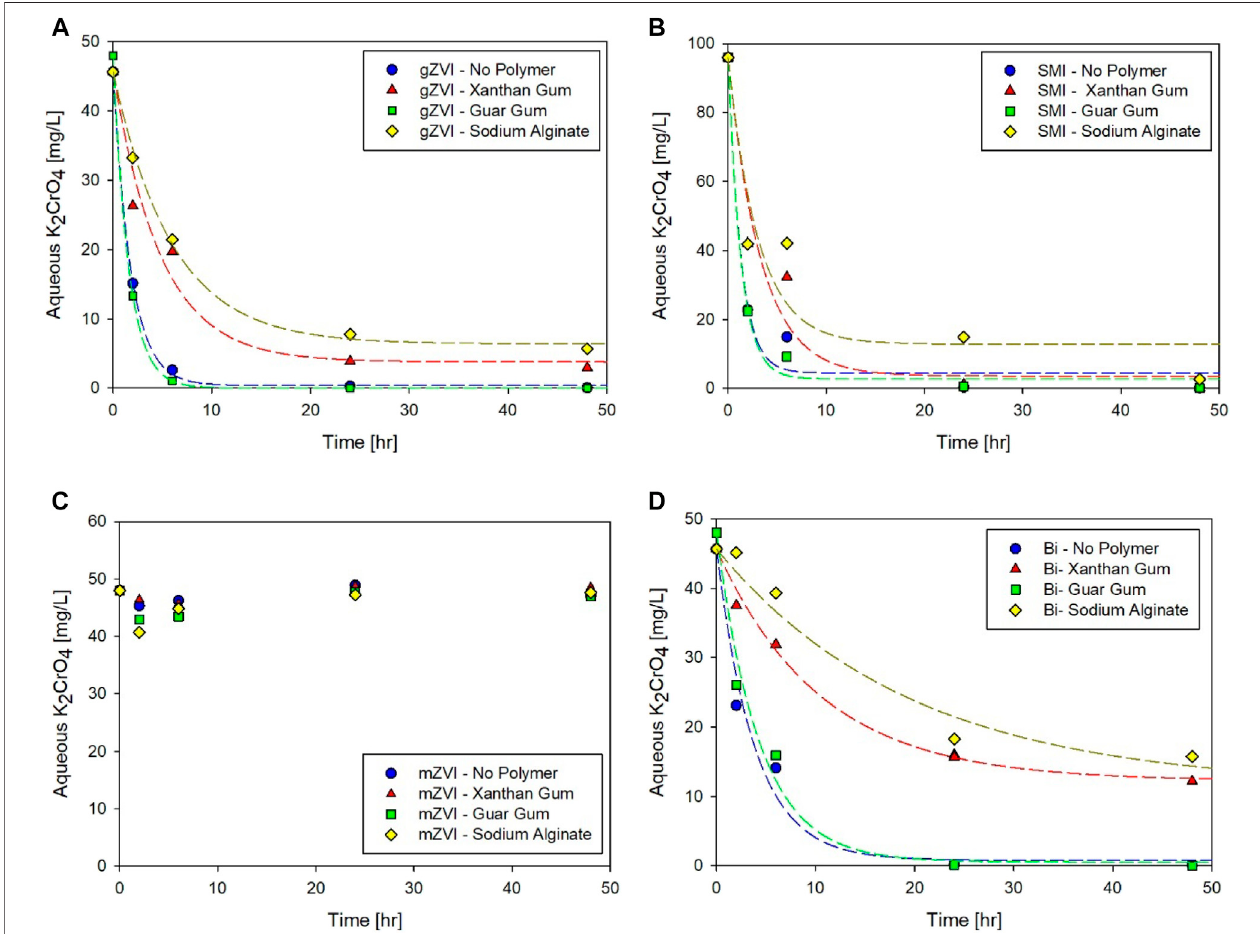
FIGURE 1 | Impact of polymer (800 mg/L) on K 2 CrO 4 treatment via (A) gZVI, (B) SMI, (C) mZVI, and (D) Bismuth sub-nitrate. Symbols indicate experimental data points for each polymer type (circle (cid:1) no polymer; triangle (cid:1) xanthan gum, square (cid:1) guar gum, diamond (cid:1) sodium alginate). Dashed lines indicate corresponding kinetic model fi ts ( Eq. 1 ). The relative error associated with experimental replicates ranged from 0 – 11% (average